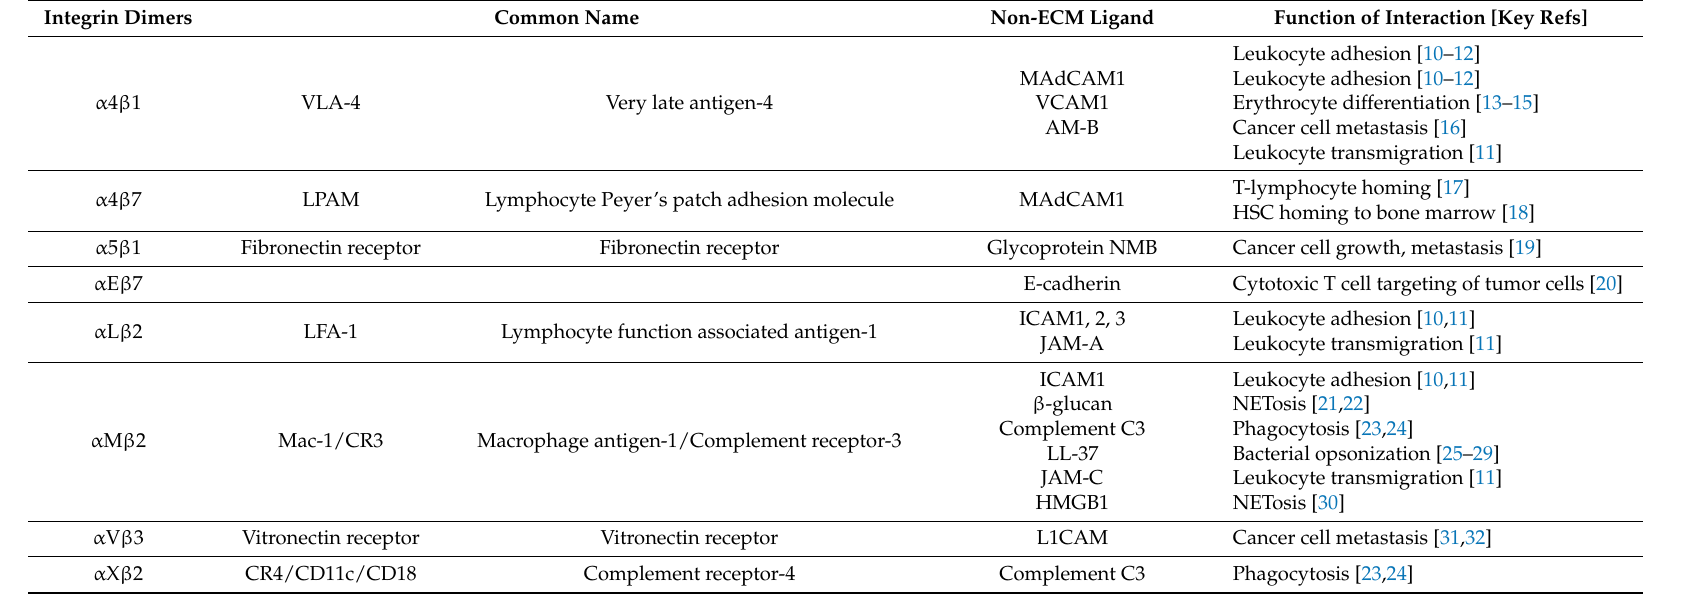
Table 1. Selected non-ECM ligands which mediate cell-cell